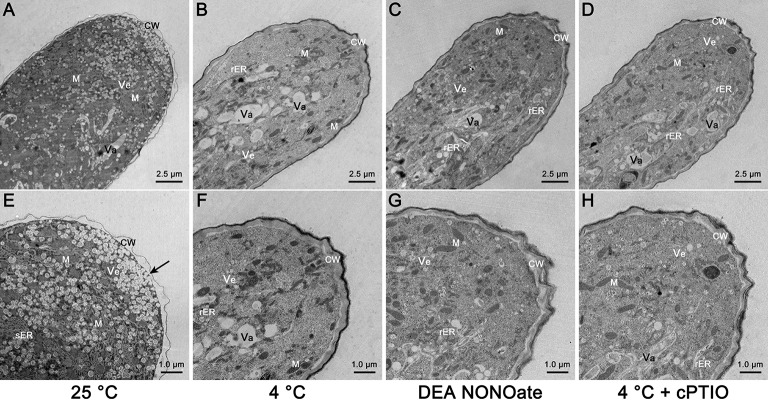
Electron micrographs of C. sinensis pollen tubes after 1 h of cold stress or DEA NONOate treatment. The extreme apical zone of the control pollen tube was filled with numerous secretory vesicles (Ve), and a large number of other organelles, particularly mitochondria (M) and smooth endoplasmic reticulum (sER), and wrapped in a thin, translucent, bumpy cell wall (A,E). The black arrows indicate the fusion of vesicles with the plasma membrane (E). The polarized distribution of vesicles, mitochondria and sER was disrupted, and rough endoplasmic reticulum (rER) and vacuoles (Va) existed in the tip region; the morphology of the cell wall (CW) was changed by the cold stress (B,F) or 25 μM DEA NONOate treatment (C,G). Treatment with 200 μM cPTIO effectively reduced the effects of cold stress on the cell wall ultrastructure, but there were negligible changes in the distribution and ultrastructure of the organelles (D,H). M, mitochondria; Ve, vesicle; Va, vacuole; CW, cell wall.